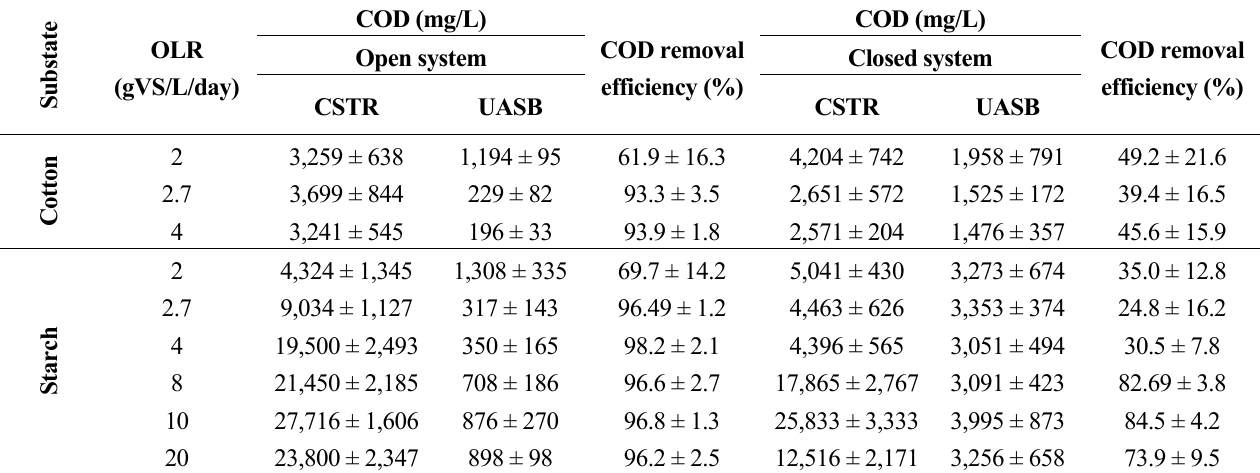
Table 2. The ratio of methane to carbon dioxide, concentration of COD and the COD removal efficiency for cotton and starch in UASB and CSTR during different organic loading